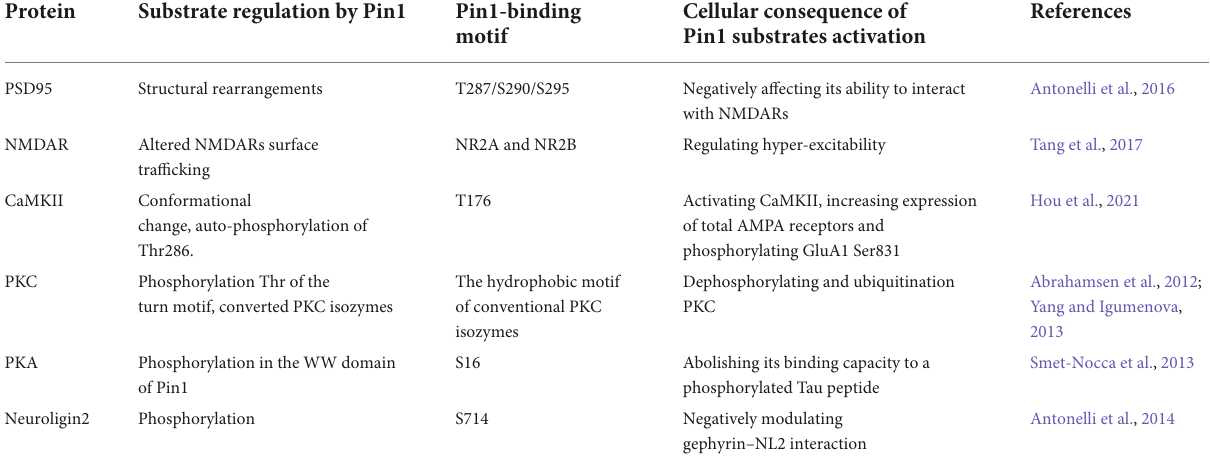
TABLE 1 Selected Pin1